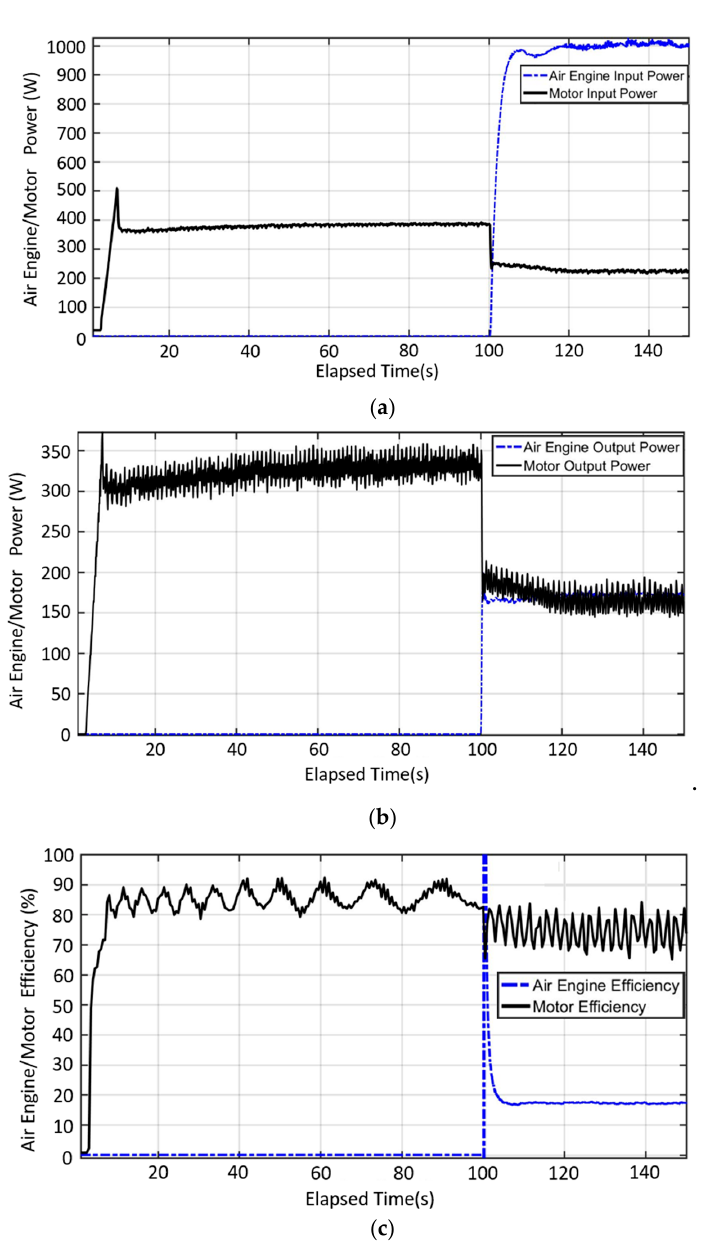
Figure 13. Hub motor / air engine hybrid mode: ( a ) input power; ( b ) output power; and, ( c ) e ffi